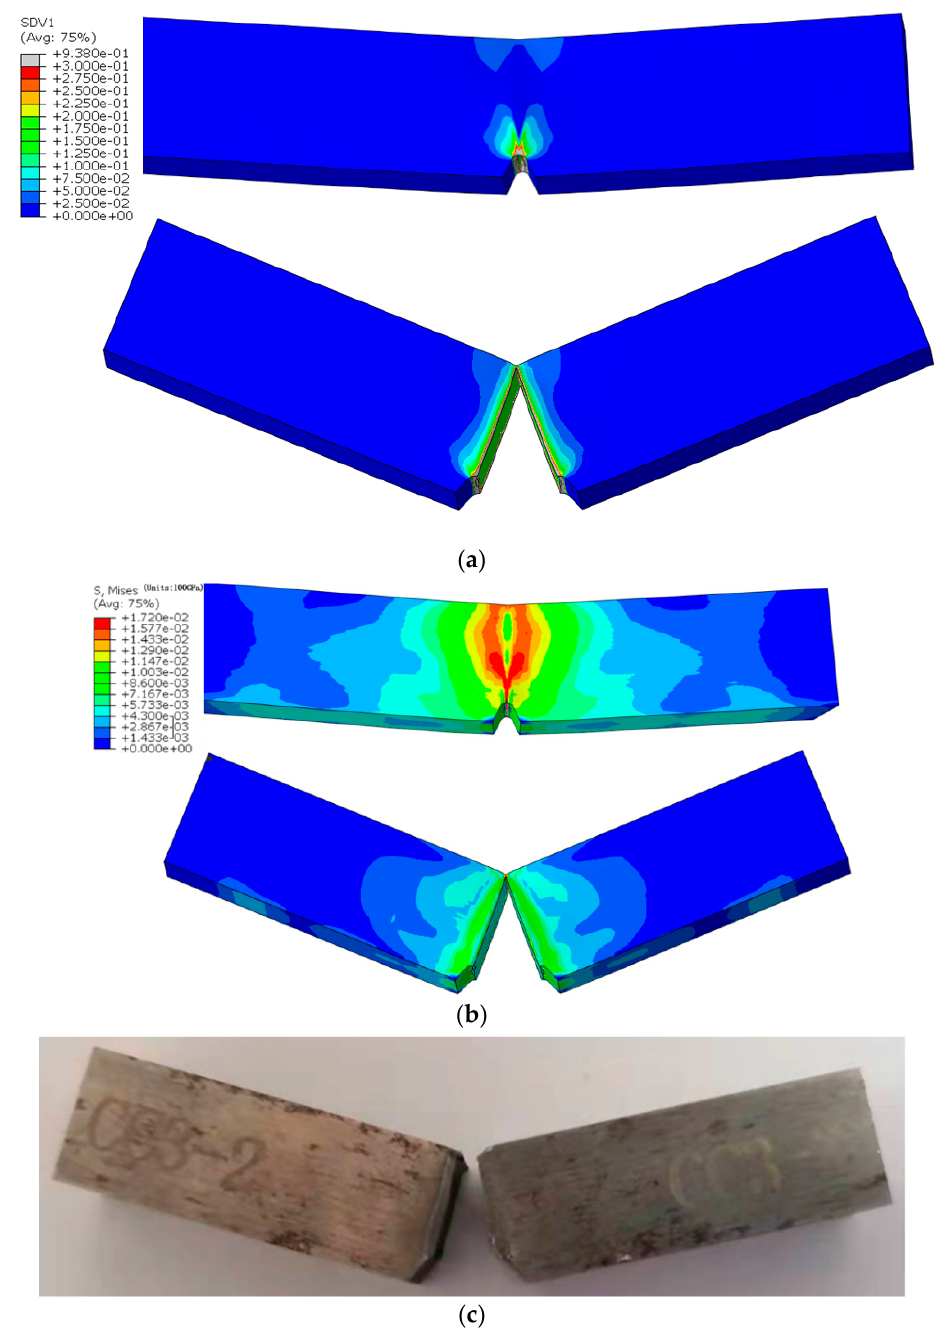
Figure 13. Comparison of deformation morphology between simulation and experimental samples; ( a ) Distribution of equivalent plastic strain (SDV1); ( b ) Distribution of Mises stress; ( c ) Experiment fracture. Table 4. Comparison of Charpy test and simulation results.